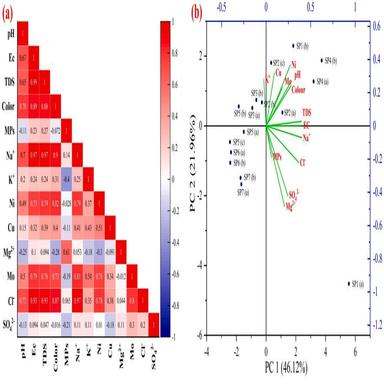
Statistical analysis conducted on GW samples collected from seven sampling points (SP): (a) Spearman correlation coefficient, (b) principal component analysis.